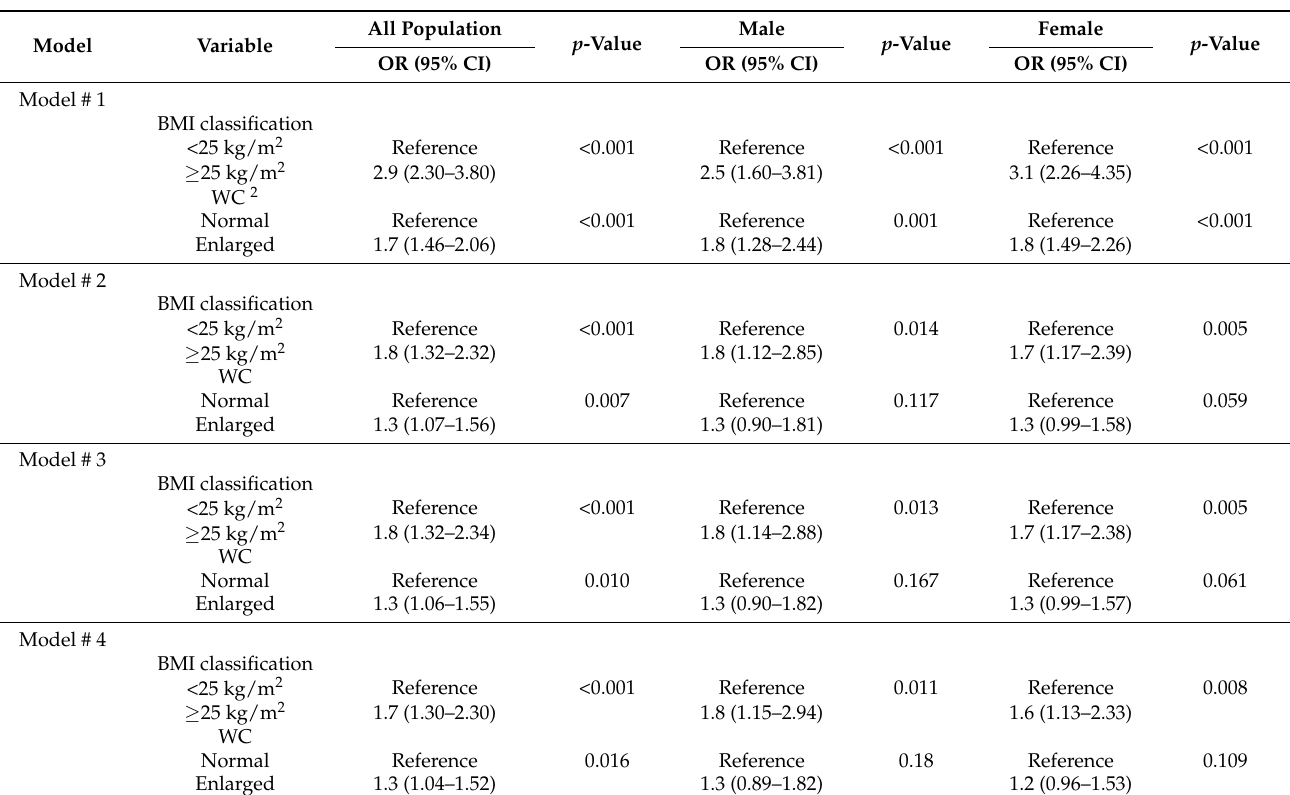
Table 5. Associations of body mass index (BMI) and WC with T2D among the study population stratified by sex 1 .